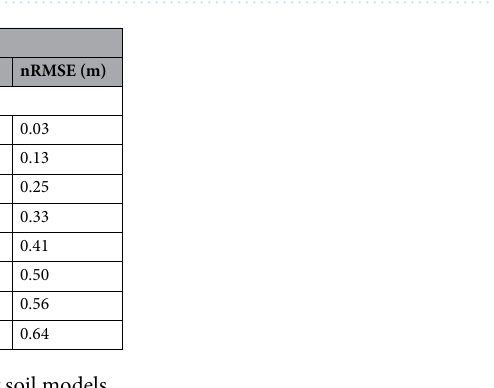
Table 7. Model performance statistics for the sandy soil models.